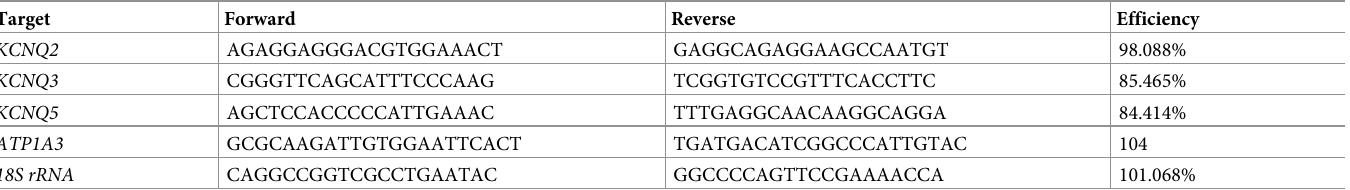
Table 1. Primer sequences for SYBR Green qPCR